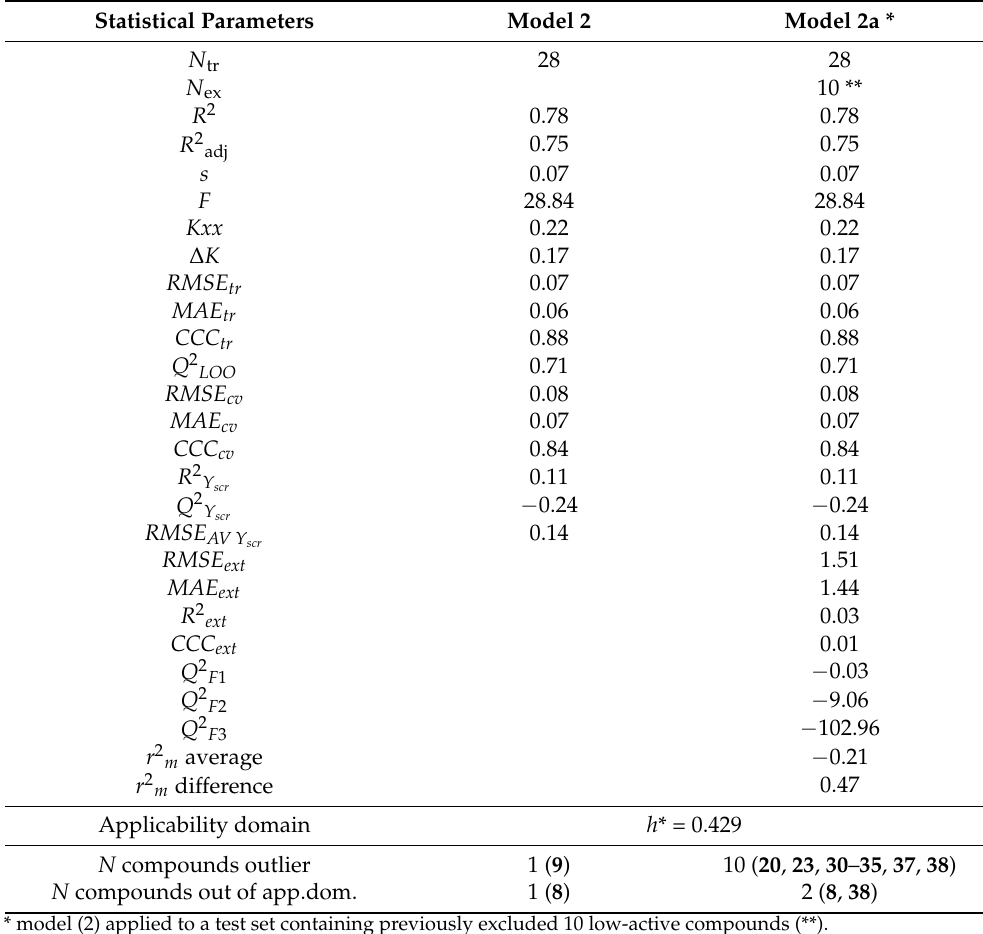
Figure 2. Pharmacophore mapping of the most active compound 23 and of the least active compound 13 against pathogen fungi M. phaseolina . (Green = hydrogen-bond acceptor; Blue = hydrophobe region). Table 6. The statistical results of QSAR model